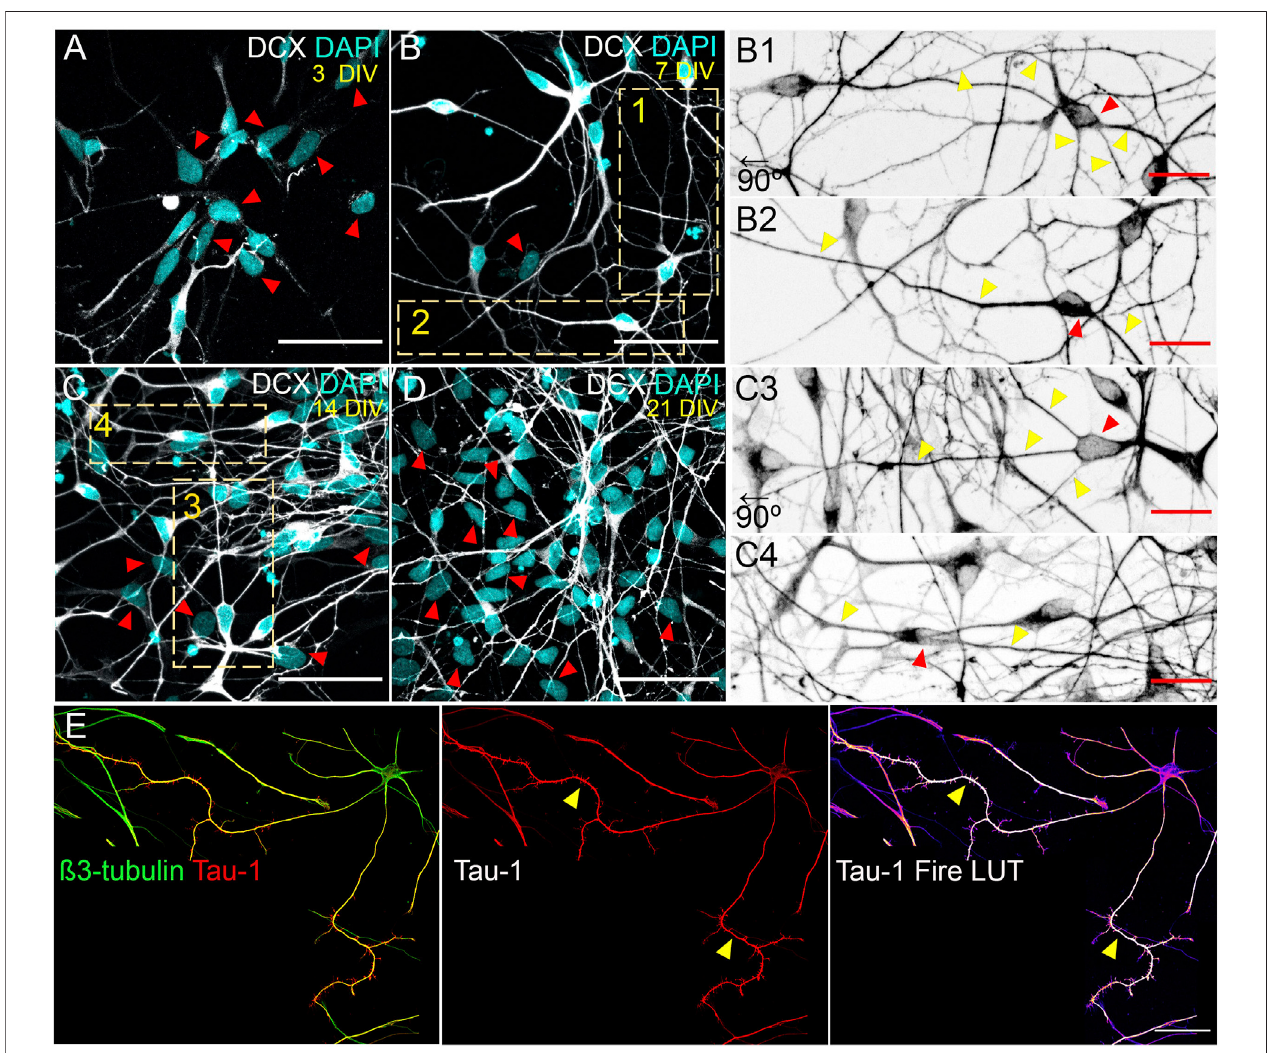
FIGURE 2 | In vitro morphological stages of hiPSC neuronal polarization. (A – D) hiPSC-derived neurons at 3, 7, 14 and 21 DIV expressing Doublecortin (DCX; postmitoticneuronmarker).Scale:50 µm.Insets1-2(7DIV)and3-4(14DIV)areshowntovisualizemainmorphologiesdetectedinculture. (B1,2,C3,4) Magni fi cationon insets in B and C images. Insets B1 and C3 were rotated at 90 ° left for aesthetic purposes. Scale: 20 µm. (E) Molecular polarization of neurons visualized by the axonal enrichment of the Tau-1 epitope (arrows). Representative image showing a 15 DIV hiPSC neuron exhibiting the proximo-distal gradient of the Tau-1 epitope as it occurs in rat neurons. Scale: 50 µm. hiPSCs from skin fi broblasts generated using the Yamanaka factors were gently provided by Dr. Fernando Pitossi (Fundación Instituto Leloir, FIL-CONICET, CABA, Argentina). They were differentiated into cortical neurons following established protocols (Casalia et al., 2021). Immuno fl uorescence and confocal microscopy was performed using established protocols (Wilson et al., 2020b).